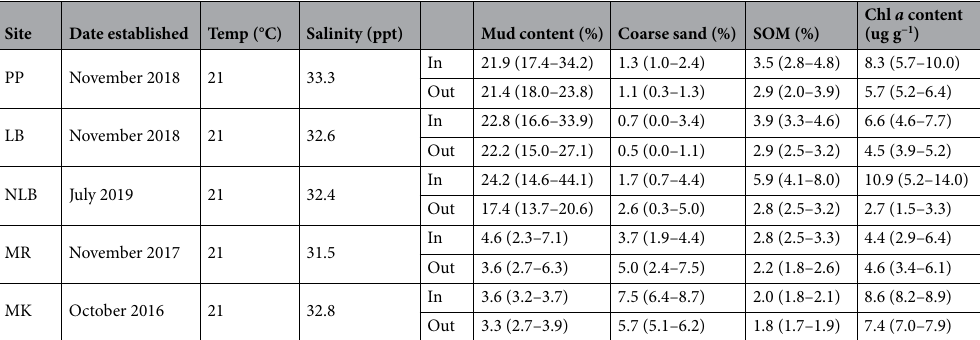
Table 1. Mean and range of environmental characteristics measured at each site, separated by restoration status (inside vs. outside mussel beds). Mud is comprised of silt + clay (< 63 μm). Coarse sand > 500 μm. SOM = sediment organic material. Sites arranged from inner Mahurangi Harbour to outer Kawau Bay. MK sediment data from 30 . Pukapuka = PP, Lagoon Bay = LB, New Lagoon Bay = NLB, Motuora = MR, and Motoketekete =